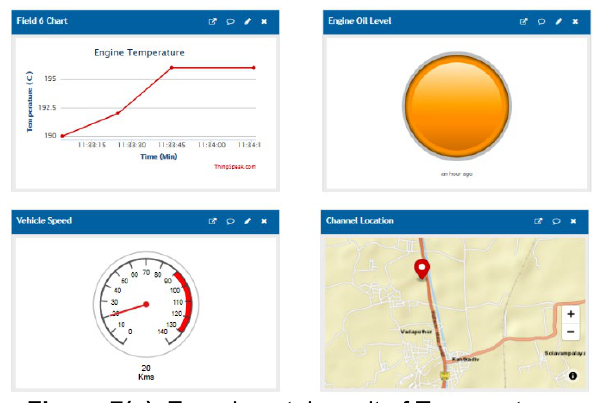
Figure 7(a) . Experimental result of Temperature, Engine oil level, Vehicle speed and live location